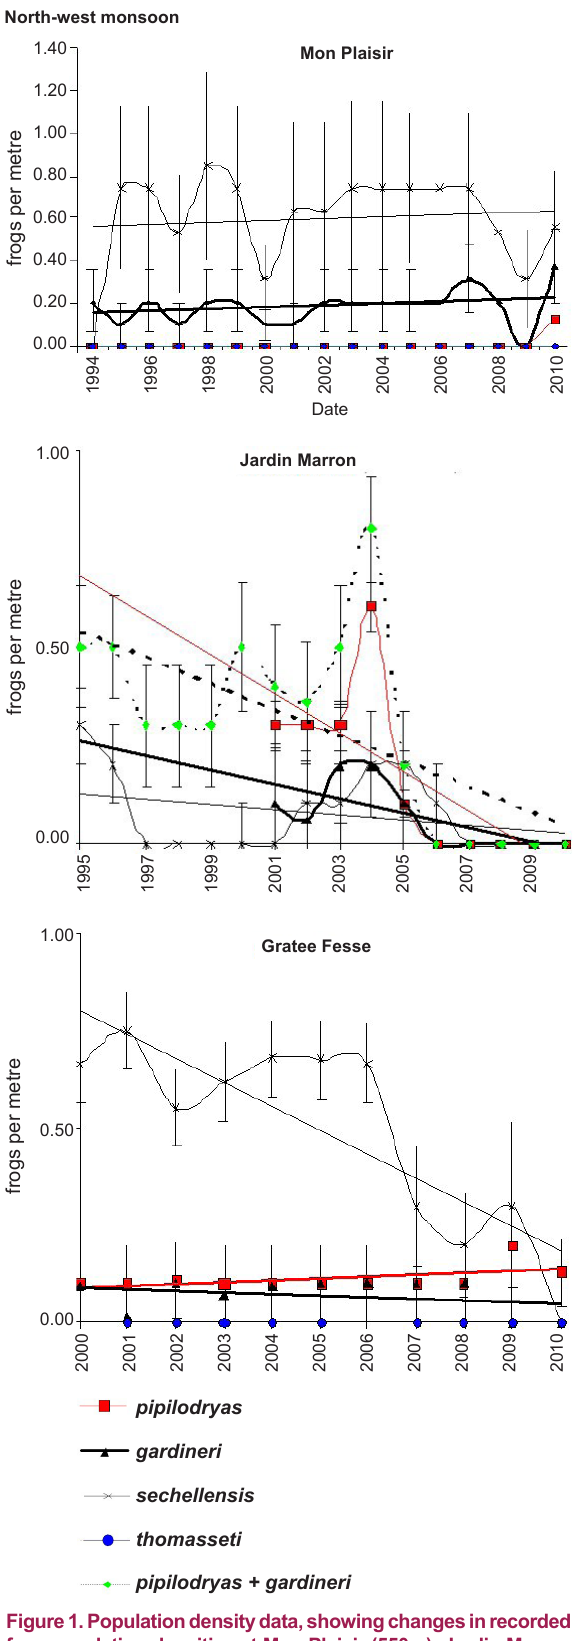
Figure 1. Population density data, showing changes in recorded frog population densities at Mon Plaisir (550m), Jardin Marron (390m), Gratte Fesse (350m) and the Pisonia forest